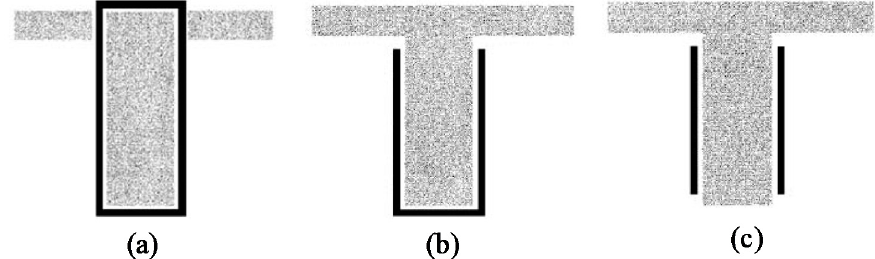
Figure 13. Wrapping schemes for EB FRP shear laminates: ( a ) complete closed wrapping, ( b ) 3-sided U-wraps, and ( c ) 2-sided face plies [28].